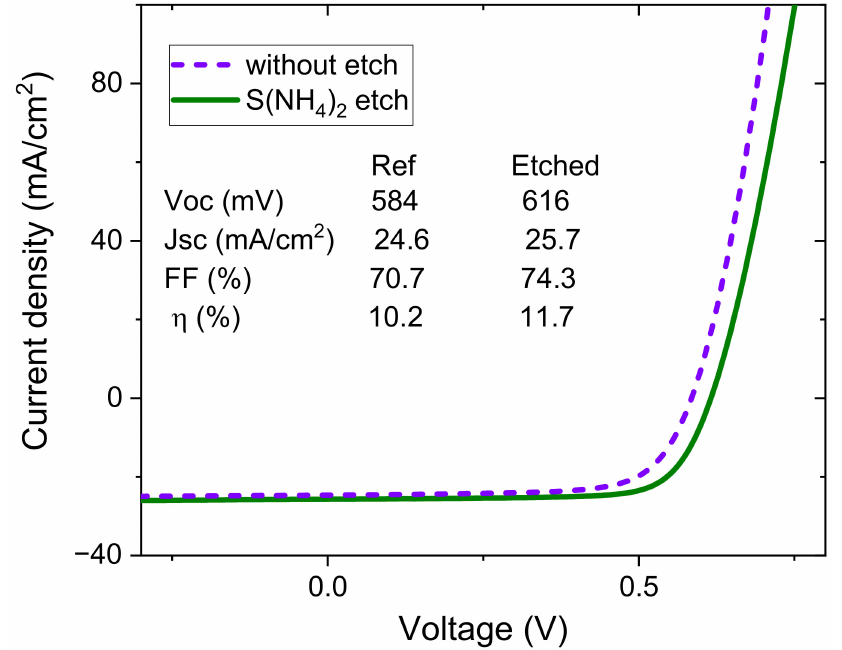
Figure 11. JV curves and parameters of the best solar